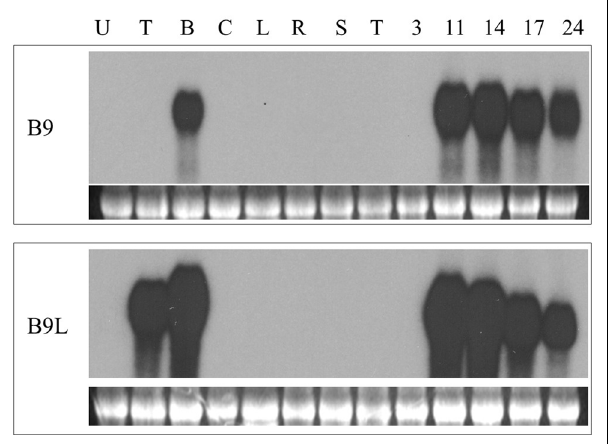
FIGURE 1 | Northern blot analyses of the expression of BETL9 and BETL9like . The probe used in each northern blot is indicated on the left. Each panel contain an EtBR picture of the ribosomal RNA to show equal loading.The tissues used as source of total RNA (10 μ g per lane) were: U, unpollinated female flowers;T, upper part of 10 DAP kernels; B, lower part of 10 Dap kernels; C, coleoptiles; L, leaves; R, roots; S, silks;T, tassel (male flowers); 3, 11, 14, 17, and 24, complete kernels collected at the indicated developmental stage (in